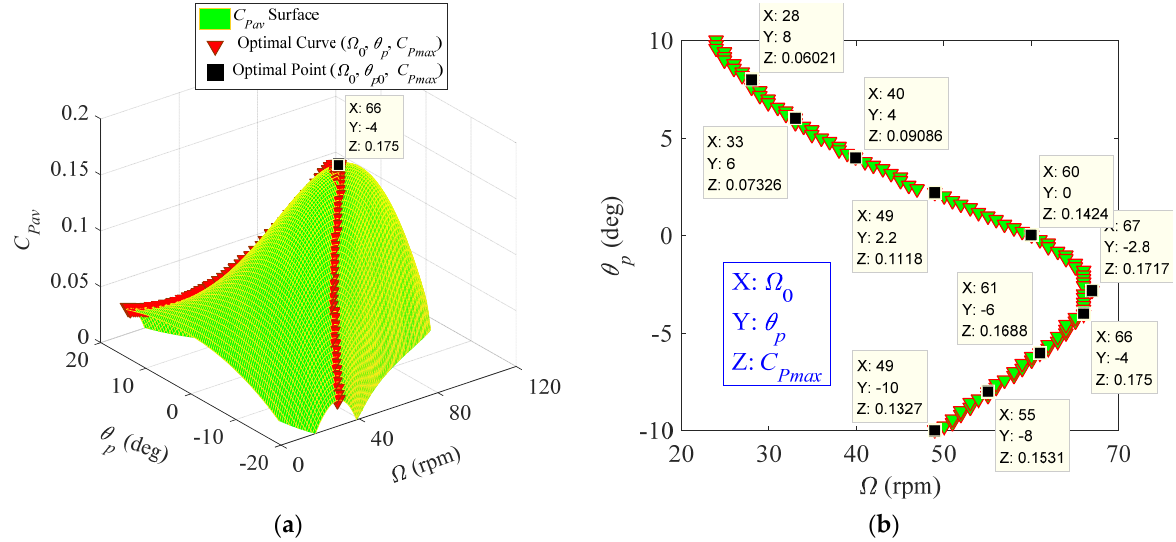
Figure 13. Variation of the power coefficient with the rotational speed and pitch angle at the fixed v in = 11.18 mph: ( a ) three-dimensional surface; and ( b ) two-dimensional projection of the optimal-power curve.